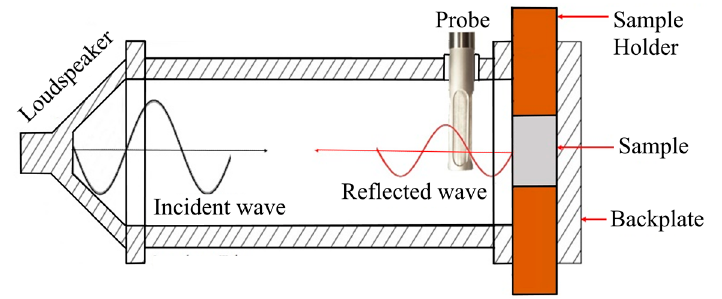
5 of 20 Figure 3. Detail of impedance tube and sample assembly for sound absorption testing.